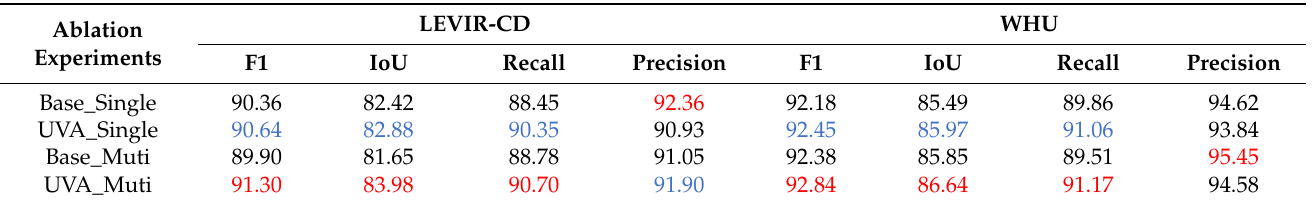
Table 4. The ablation experiments results on LEVIR-CD and WHU. All values are reported as percentages (%).